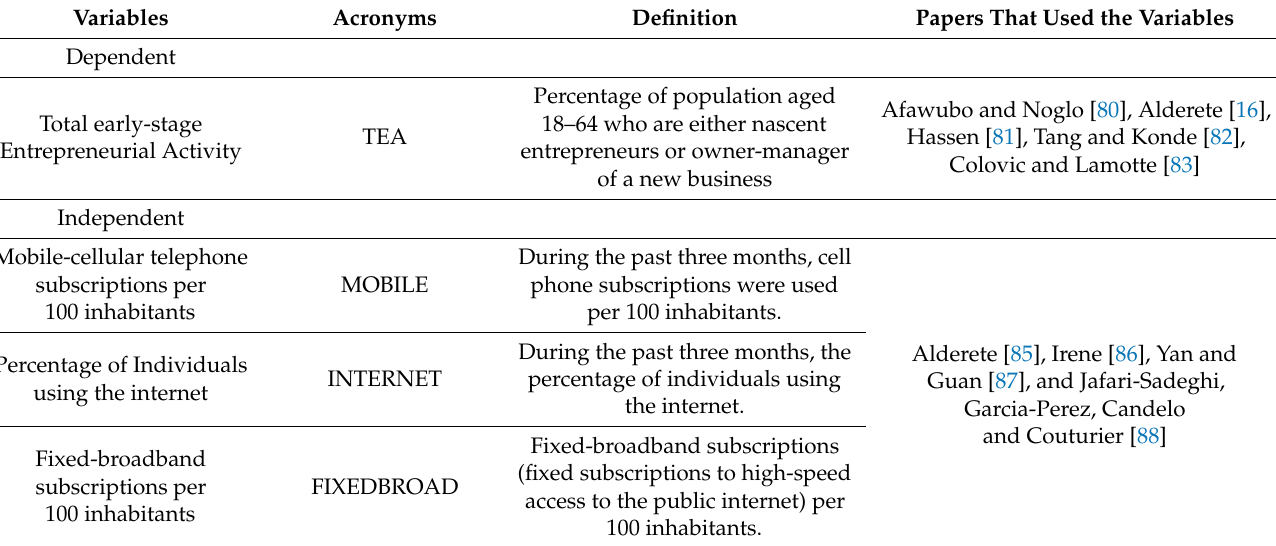
Table 1. Dependent and independent